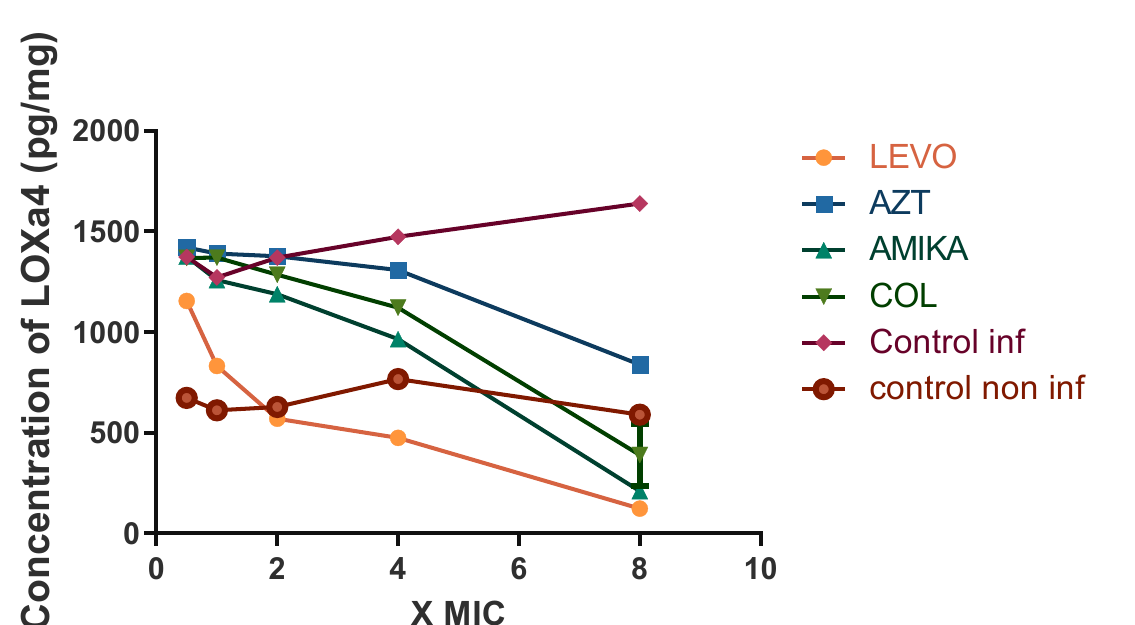
Figure 6. Concentration of LOXa4 (pg/mg of protein) in extracts of human lung epithelial NCI-H292 cells infected, noninfected, and treated with antibiotics after 24 h. (LEVO = levofloxacin, AZT = aztreonam, AMIKA = amikacin, COL = colistin, Control inf = control in infected cells, Control non inf = control in noninfected cells).